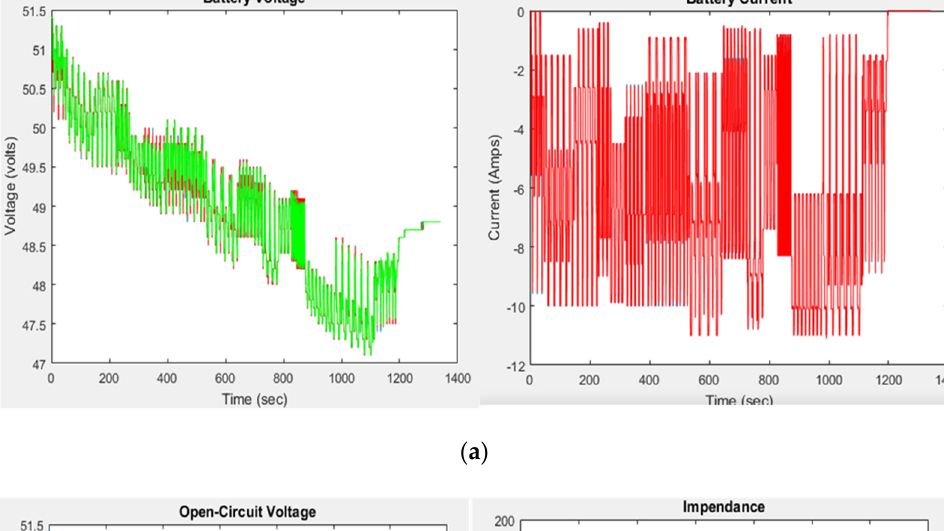
Figure 10. ( a ) Voltage drop and discharge current; ( b ) comparison of online estimating open-circuit voltage (OCV) and internal resistances (IRs) with the offline numerical model.